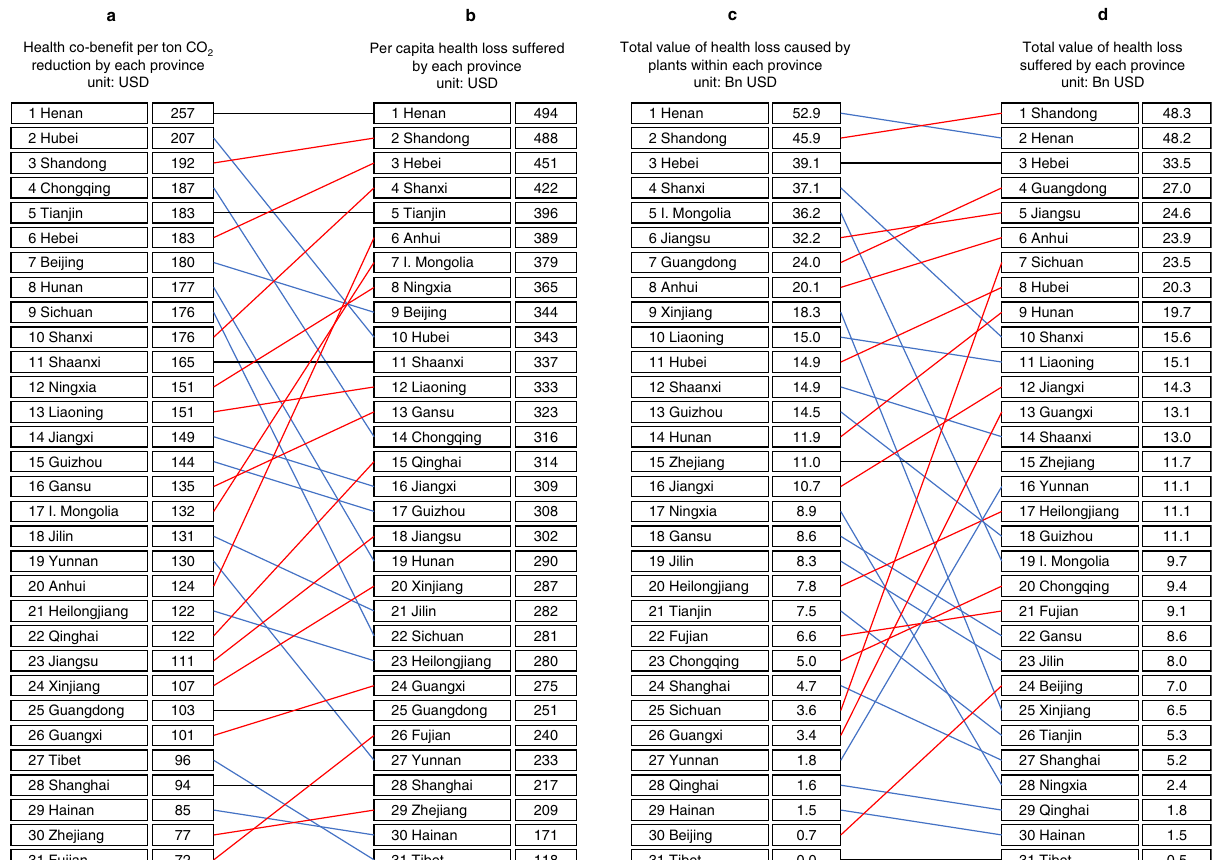
Fig. 3 The difference between health cost valuations based on emission sources vs. the affected regions. a Value of health co-bene fi t from reducing one ton CO 2 emissions from coal- fi red power plants located in each province; b Per capita health loss suffered by each province due to air pollution caused by all coal plants in China in 2017; c total value of health loss caused by coal plants within each province; d total value of health loss suffered by each province due to air pollution caused by all coal plants in China in 2017. Provinces connected by blue lines have power plants that are relatively more damaging, but these provinces suffer relatively less; provinces connected by red lines have relatively less damaging power plants, but these provinces suffer more from coal- fi red power